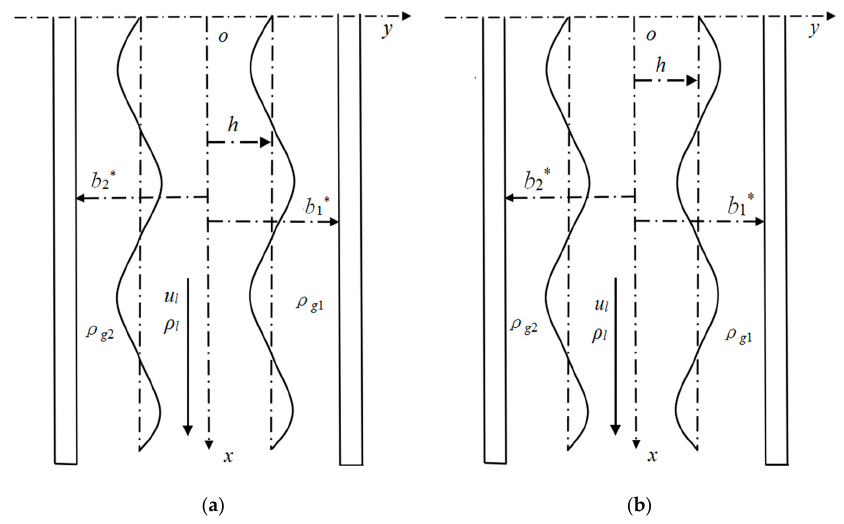
Figure 1. Schematic diagram of a power-law liquid jet in two asymmetric bounded gas media and interface waves: ( a ) para-sinuous mode and ( b ) para-varicose mode.